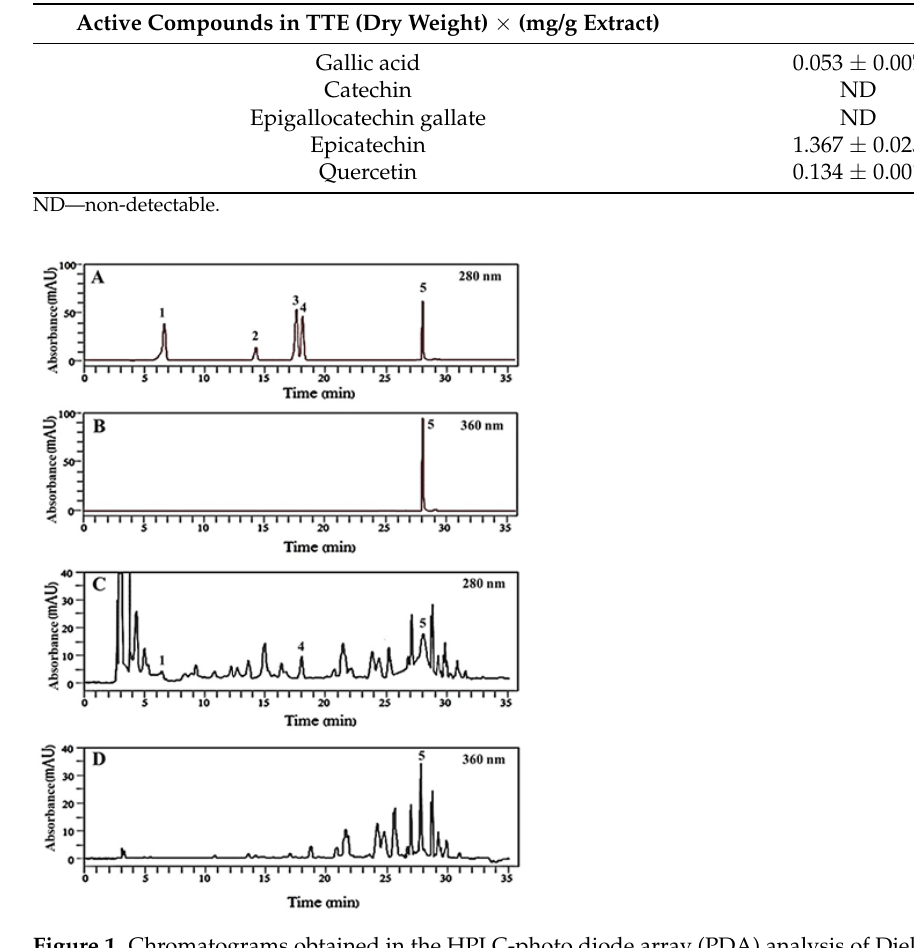
Table 1. The composition of phenolic and flavonoid compounds in TTE analyzed by HPLC-PDA.